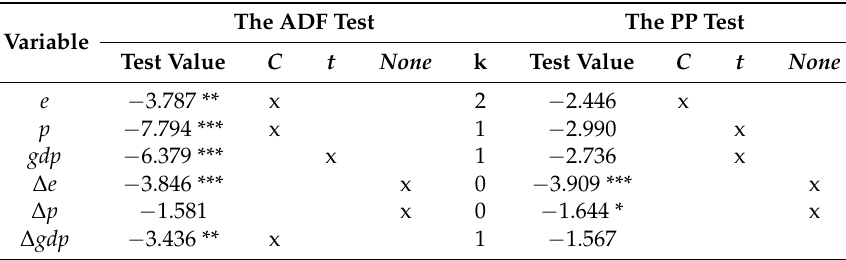
Table 1. The Unit Root test results.